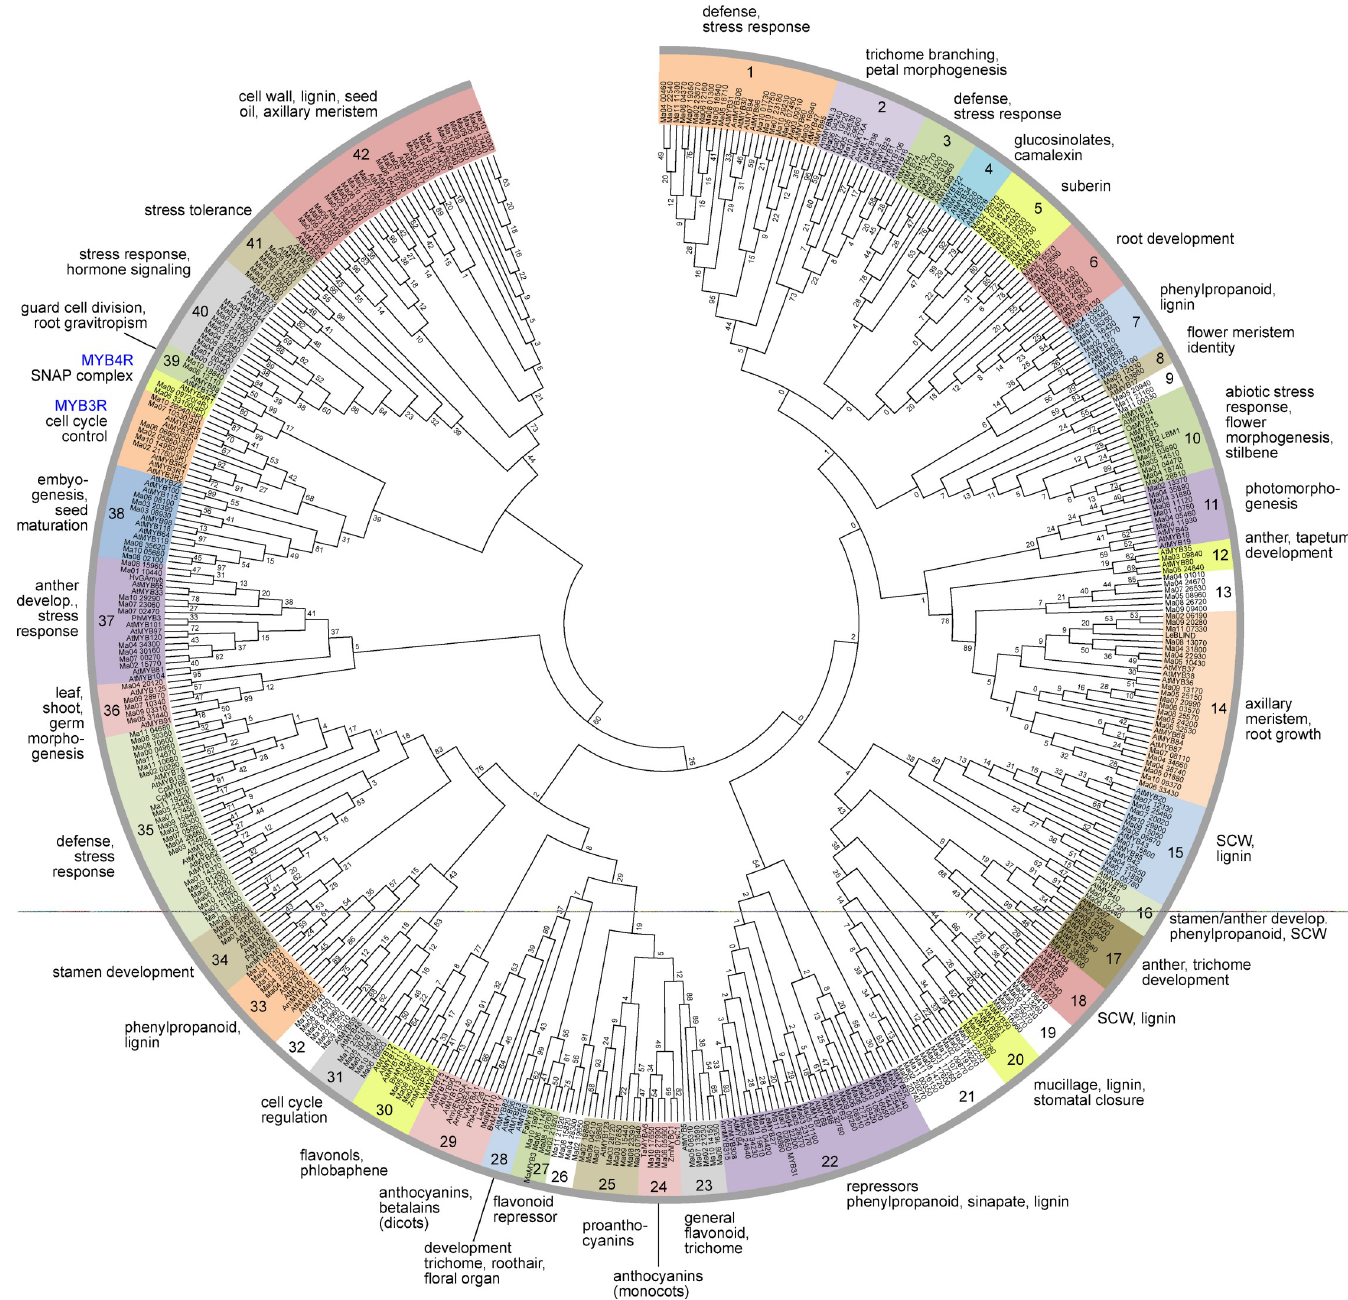
Fig 2. Phylogenetic Maximum Likelihood (ML)